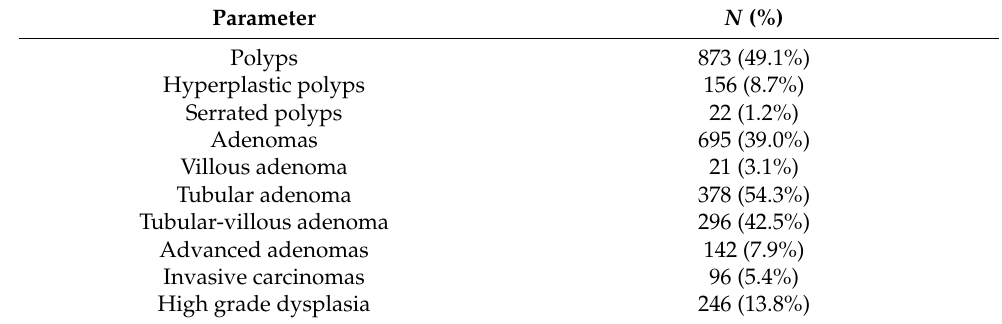
Table 2. Detection rates at colonoscopy.